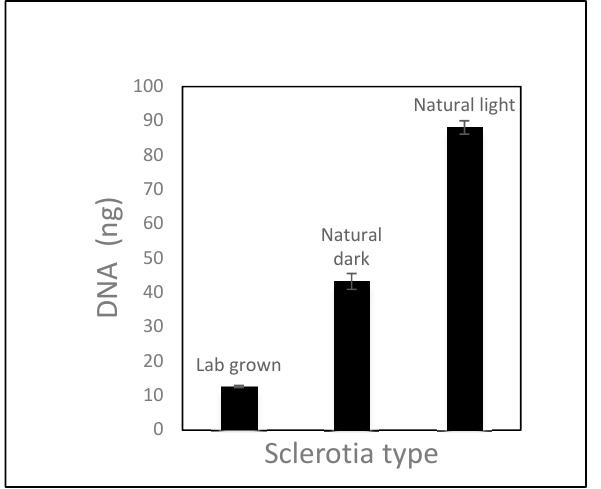
Figure 3. Sensitivity of detection of Rhizoctonia tuliparum DNA from lab-grown, natural-light, and natural-dark sclerotia. DNAs were extracted from 14.25 mg sclerotia (equivalent of eight average size sclerotia) of three different types in triplicate diluted 1/1000 and analyzed by qPCR. The detected DNAs for each type were plotted in a bar chart with error bars representing one standard deviation from the mean.